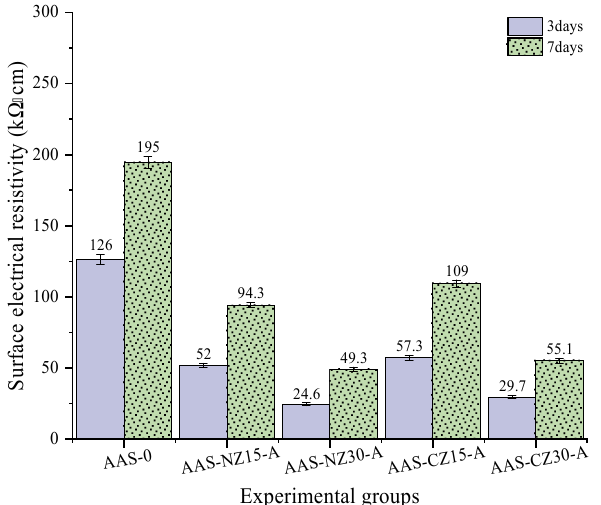
Figure 8. Surface electrical resistivity of the alkali-activated slag (AAS) mortars at 3 and 7 days.